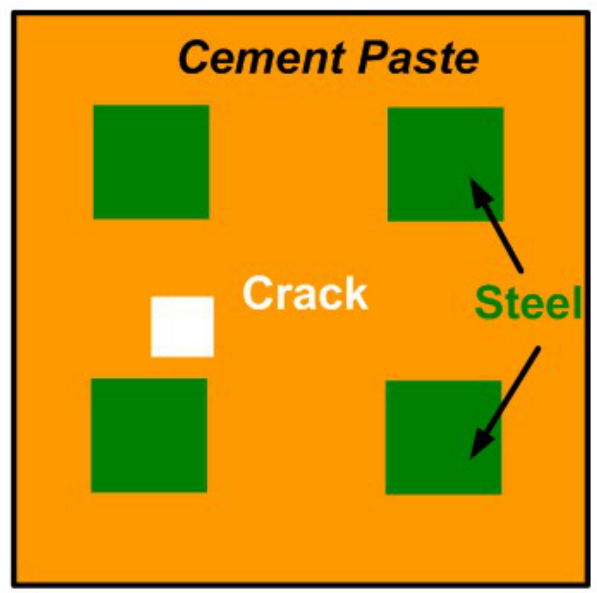
Figure 34. Civil structure